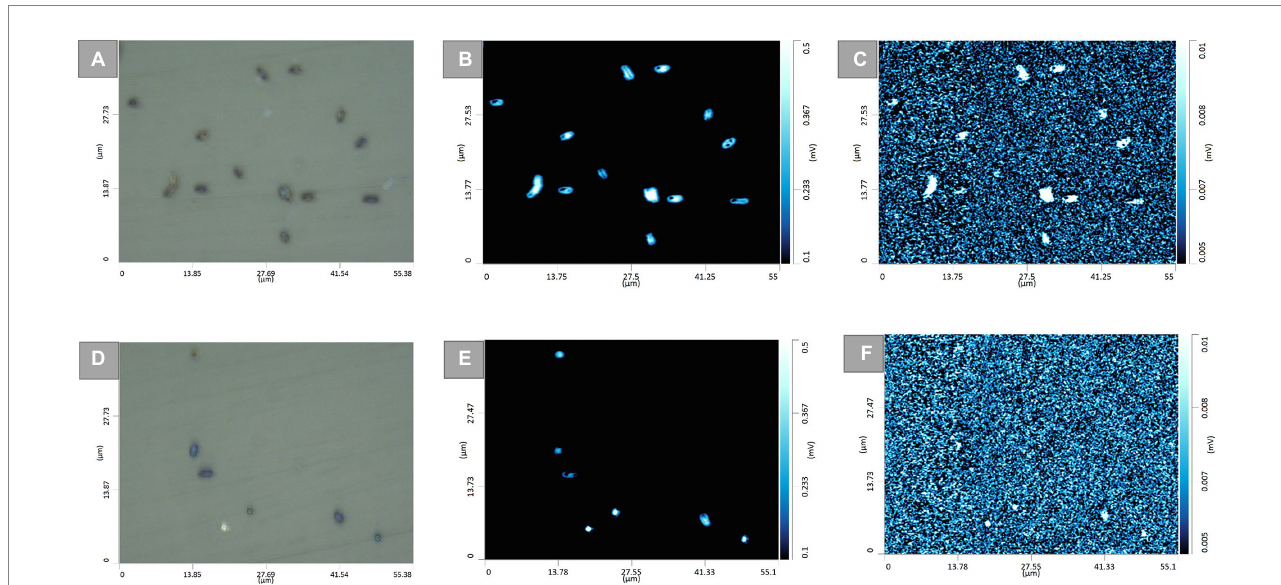
FIGURE 5 Optical images of untreated (A) , and TMP-treated (D) E. coli cells (isolate 147, TMP-sensitive). The corresponding single-frequency O-PTIR images were obtained using the amide I vibration at 1,655 cm − 1 for the untreated (B), and TMP-treated (E) cells, and the C–D vibration at 2,163 cm − 1 for the untreated (C) , and TMP-treated (F)